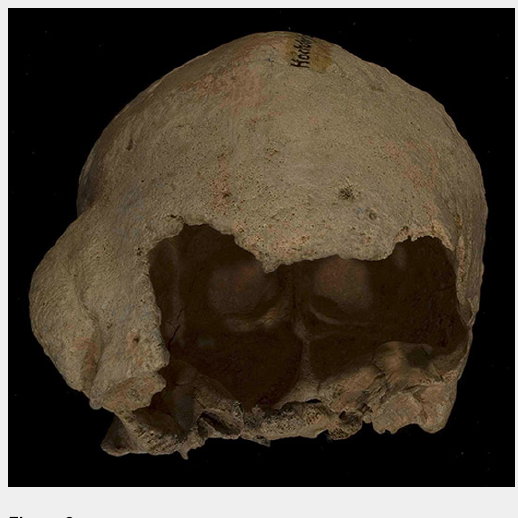
Figure 2 Skull with intensely calcified bone proliferation at the right side of the os